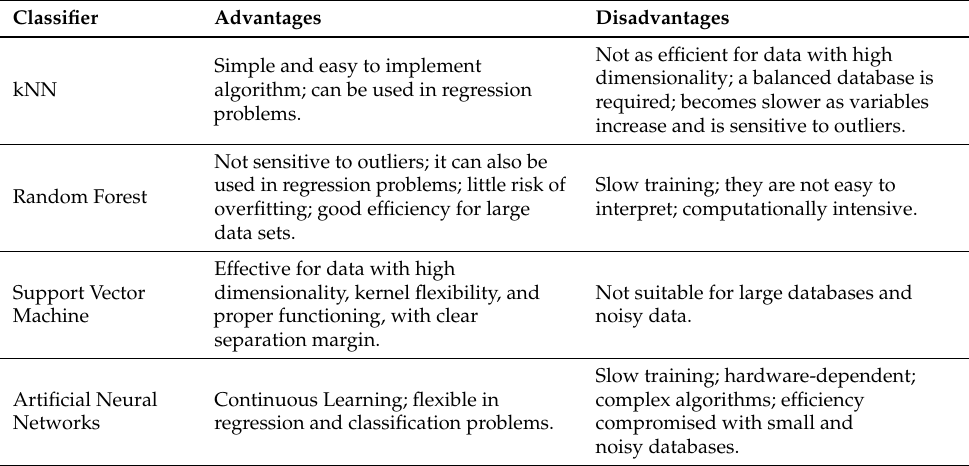
Table 3. Advantages and disadvantages of the discriminatory models.